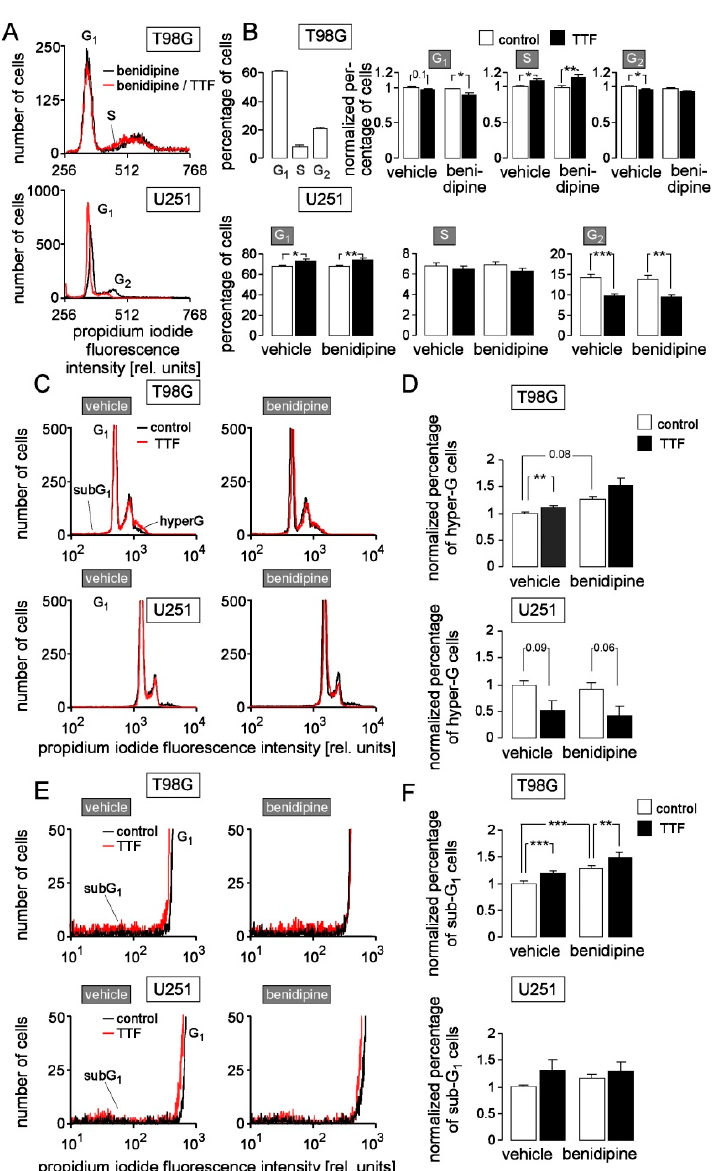
Figure 7. TTFields stimulate a G 1 or S cell cycle arrest in T98G and U251 cells and an increase in hyper-G and sub-G 1 populations in T98G cells. Benidipine (1 µM) tends to augment or significantly augments these latter effects. ( A,C,E ) Histograms recorded by flow cytometry showing the DNA content (Nicoletti staining with propidium iodide) of T98G (top) and U251 cells (bottom) treated for 7 days with TTFields of 0 (black) or 1 V/cm (red) field strength and benidipine (0 or 1 µM). ( B,D,F ) Mean (± SE; n = 12–22) percentage or normalized percentage of cells residing in G 2 , S or G 1 phase of cell cycle ( B , upper line, 2nd to 4th bar diagram and lower line; the bar diagram in the upper left gives the absolute values for the control situation in T98G), cells with elevated DNA content (hyper-G population, D ; absolute values in the control situation were 7.0 ± 0.6% for T98G and 3.9 ± 0.5% for U251), and dead cells (sub-G 1 population, F ; absolute values in the control situation were 2.8 ± 0.3% for T98G and 6.3 ± 0.4% for U251 ). *, ** and *** indicate 3 p ≤ 0.05, 3 p ≤ 0.01, and 3 p ≤ 0.001, respectively, Welch-corrected t -test and Bonferroni correction for three pairwise comparisons (vehicle/control vs. benidipine/control, vehicle/control vs. vehicle/TTFields, and benidipine/control vs. benidipine/TTFields). Numbers in ( B , upper line, 2nd diagram) and ( D ) indicate p values.